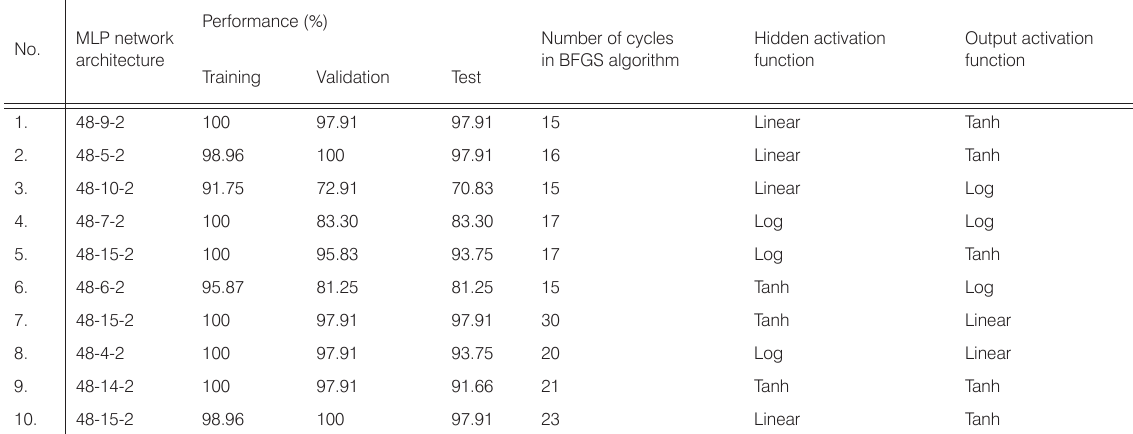
Table 3. A comparison of hidden and output activation